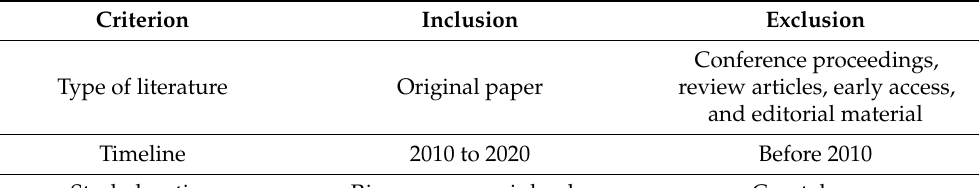
Table 1. Inclusion criteria for reviewed